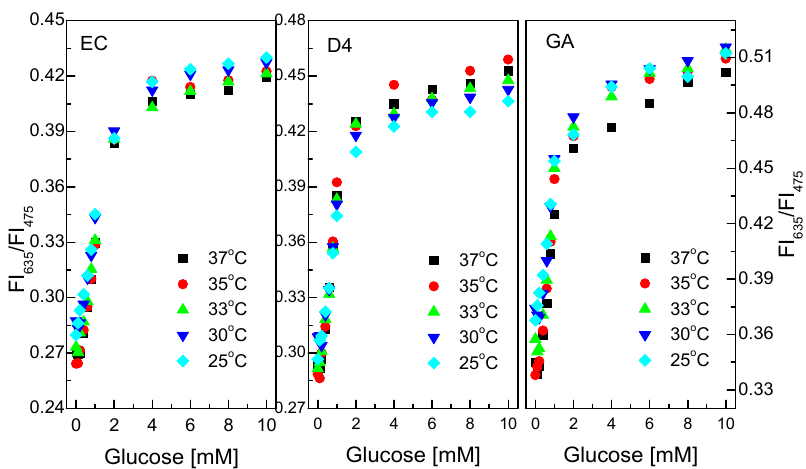
Figure 8. Responses of GOD = PS@C6^PtP membranes with different supporting materials (EC, D4, and GA) at different glucose concentrations in temperature range of 25–37 °C.